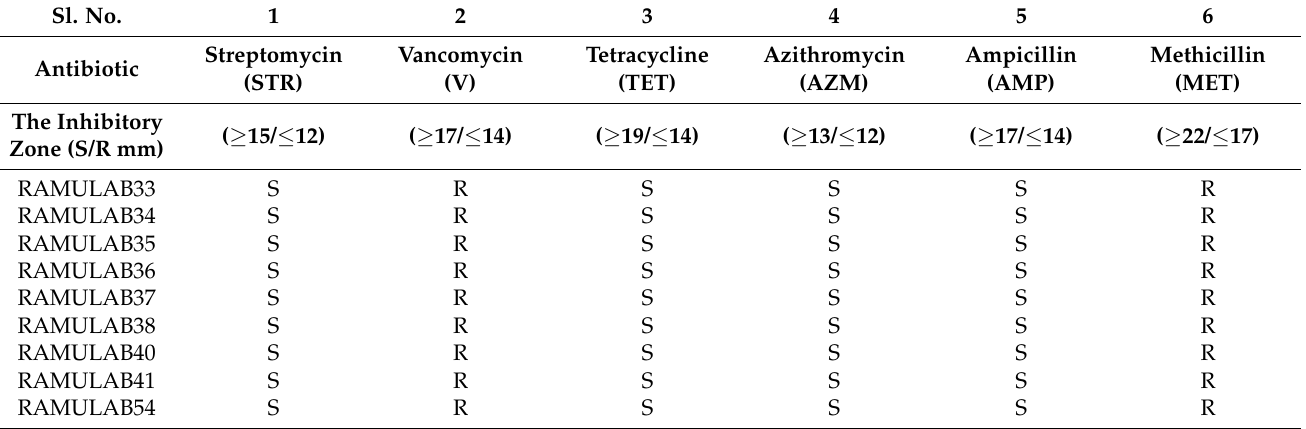
Table 7. Based on the Clinical and Laboratory Standards Institute (CLSI, 2018)’s antibiotic susceptibil- ity test results, isolates representing both resistance and sensitivity were examined [80]. Streptomycin (STR), tetracycline (TET), azithromycin (AZM), ampicillin (AMP) and methicillin (MET). The in- hibitory zone (mm) of the appropriate antibiotics is where the sensitivity/resistance breakpoints are